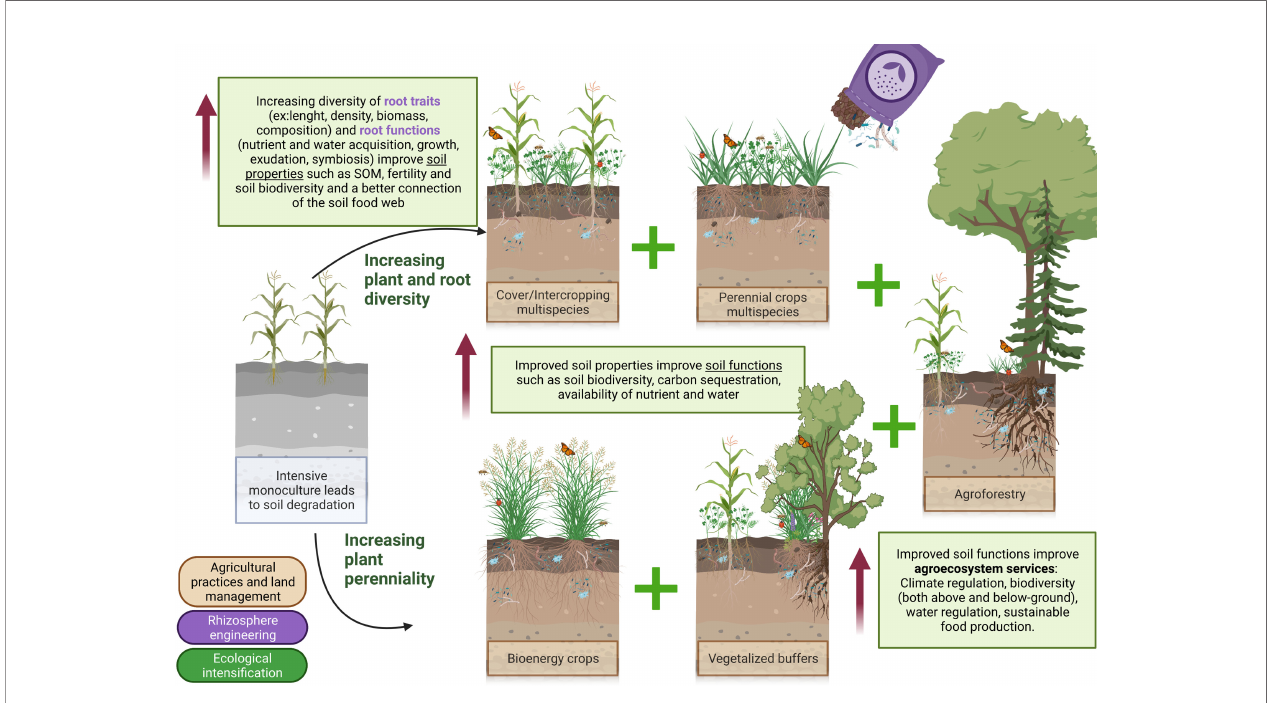
FIGURE 2 | The phytotechnology toolbox: From root and rhizosphere functions to agroecosystem services. Intensive monoculture leads to soil degradation. Increasing plant and root diversity and plant perenniality at the farm and agroecosystem scales improves soil properties, soil functions and therefore related agroecosystem services. The phytotechnology toolbox is based on three pillars. 1) Agricultural practices and land management : cover crops and intercrops in multispecies, perennials crops in the rotations including bioenergy crops, agroforestry and vegetalized buffers. 2) Rhizosphere engineering : organic amendment, inoculation and selection of plant species based on root trait and functions to achieve a speci fi c goal (improving soil fertility?, soil biology?, soil physical conditions?). 3) Ecological intensi fi cation : the more the better e.g., to multiply at the farm scale the bene fi cial agricultural practices. Increasing at the farm and agroecosystems scales the integration of the three pillars included in the phytotechnology toolbox will bene fi ts degraded soil and improves the sustainability of food production.